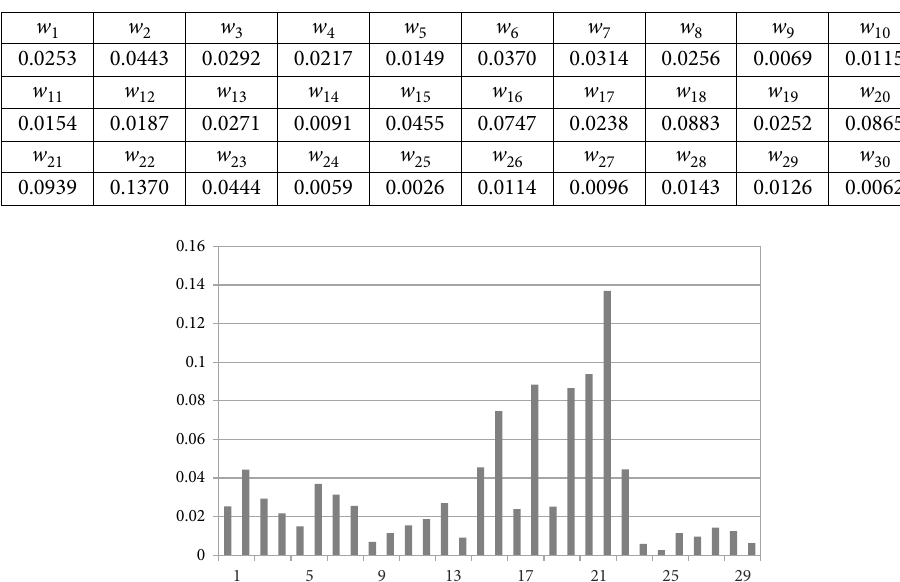
Figure 6. Objective criteria weights after using the aggregation operator (18)